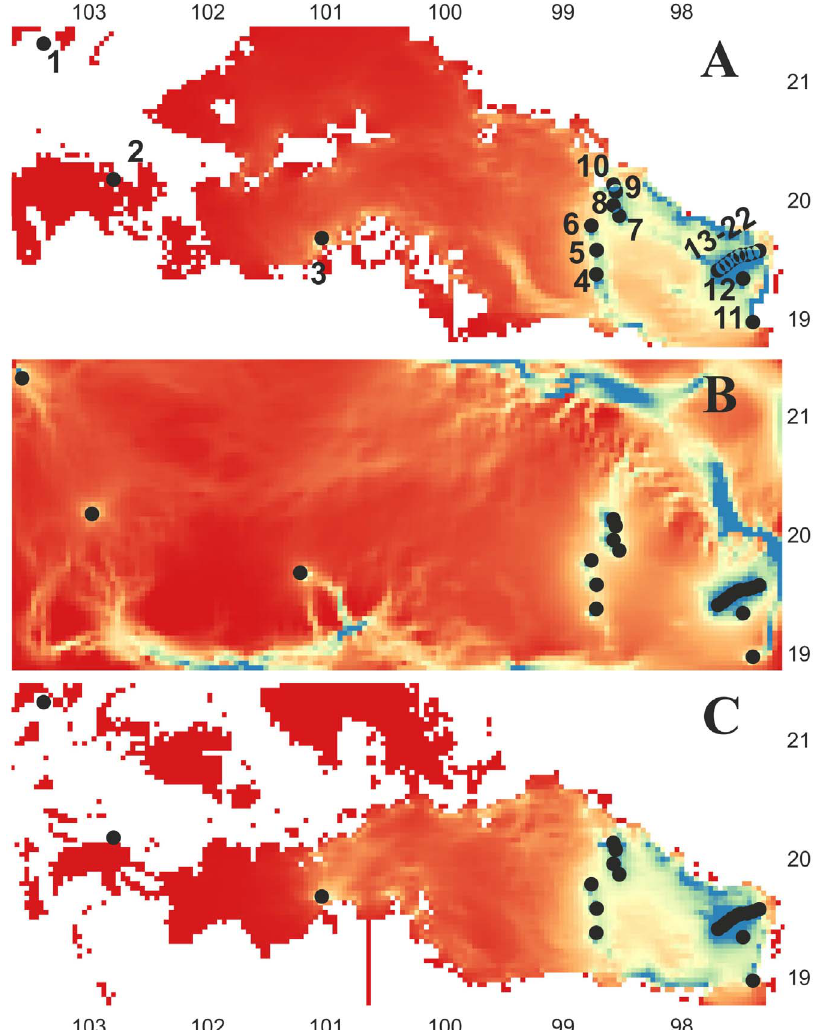
Figure 4. Connectivity maps among populations (black circles) for Nolinaparviflora . A = current environment, B = Last Glacial Maximum under the CCSM model, and C = Last Glacial Maximum under the MIROC model. Blue and light shades of blue indicate areas with higher current density; areas where connectivity is most tenuous are shown in yellow to red colours.